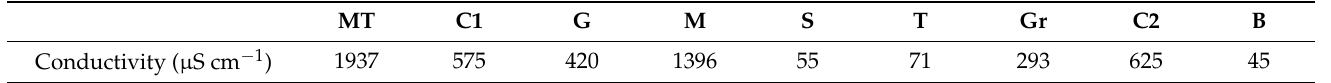
Table 2. Conductivity of each water sample.